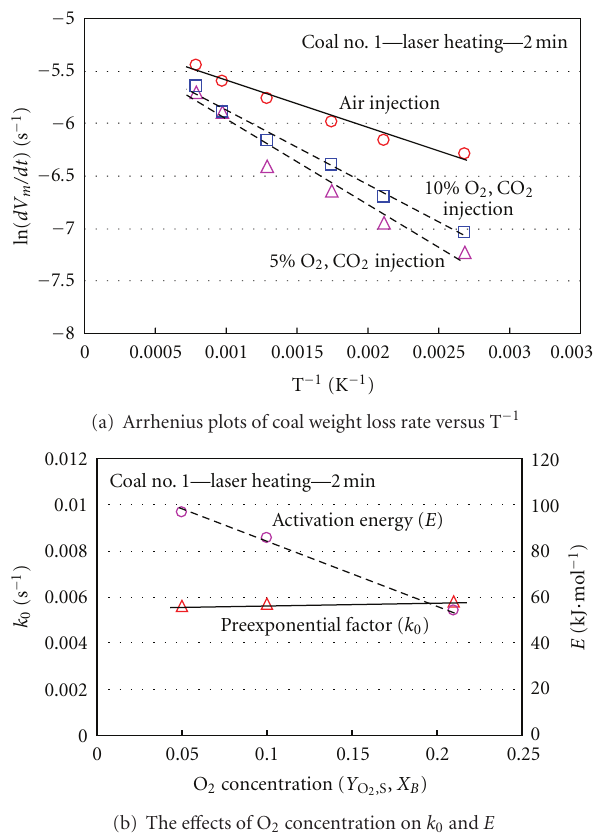
Figure 11: Coal weight loss rate with di ff erent temperature or O 2